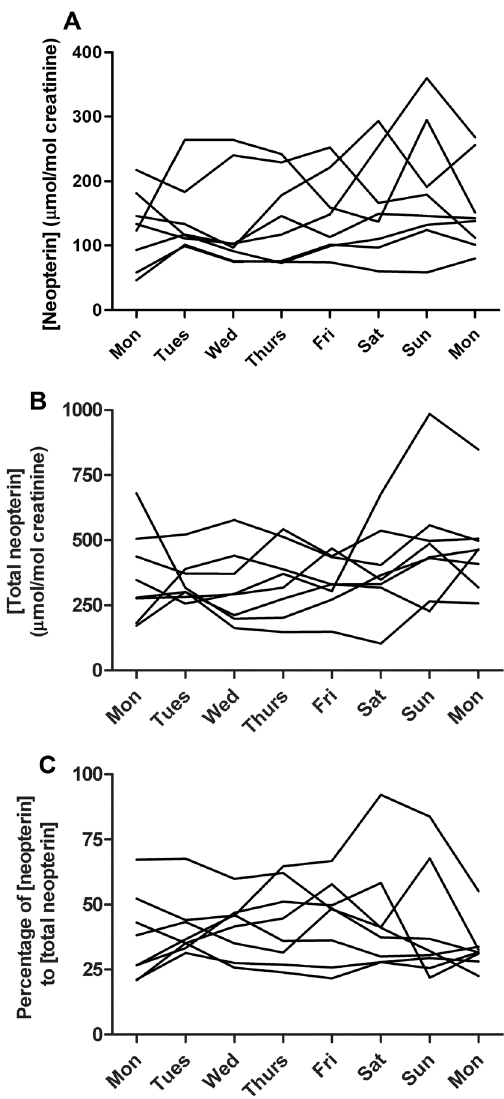
Figure 4 Urinary neopterin concentration (A) and total neopterin (B) corrected with creatinine for individual body builders. The percent neopterin as a measure of oxidation of 7,8-dihydroneopterin to neopterin is displayed for the individuals over the course of train- ing, using creatinine to correct for urine